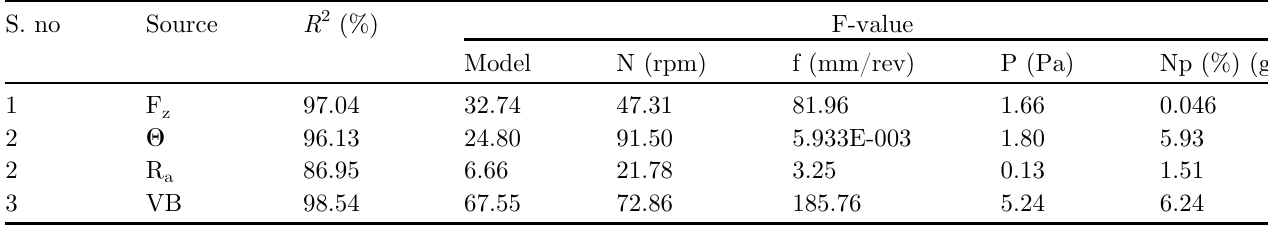
Table 5. ANOVA (F-value) table for the responses.